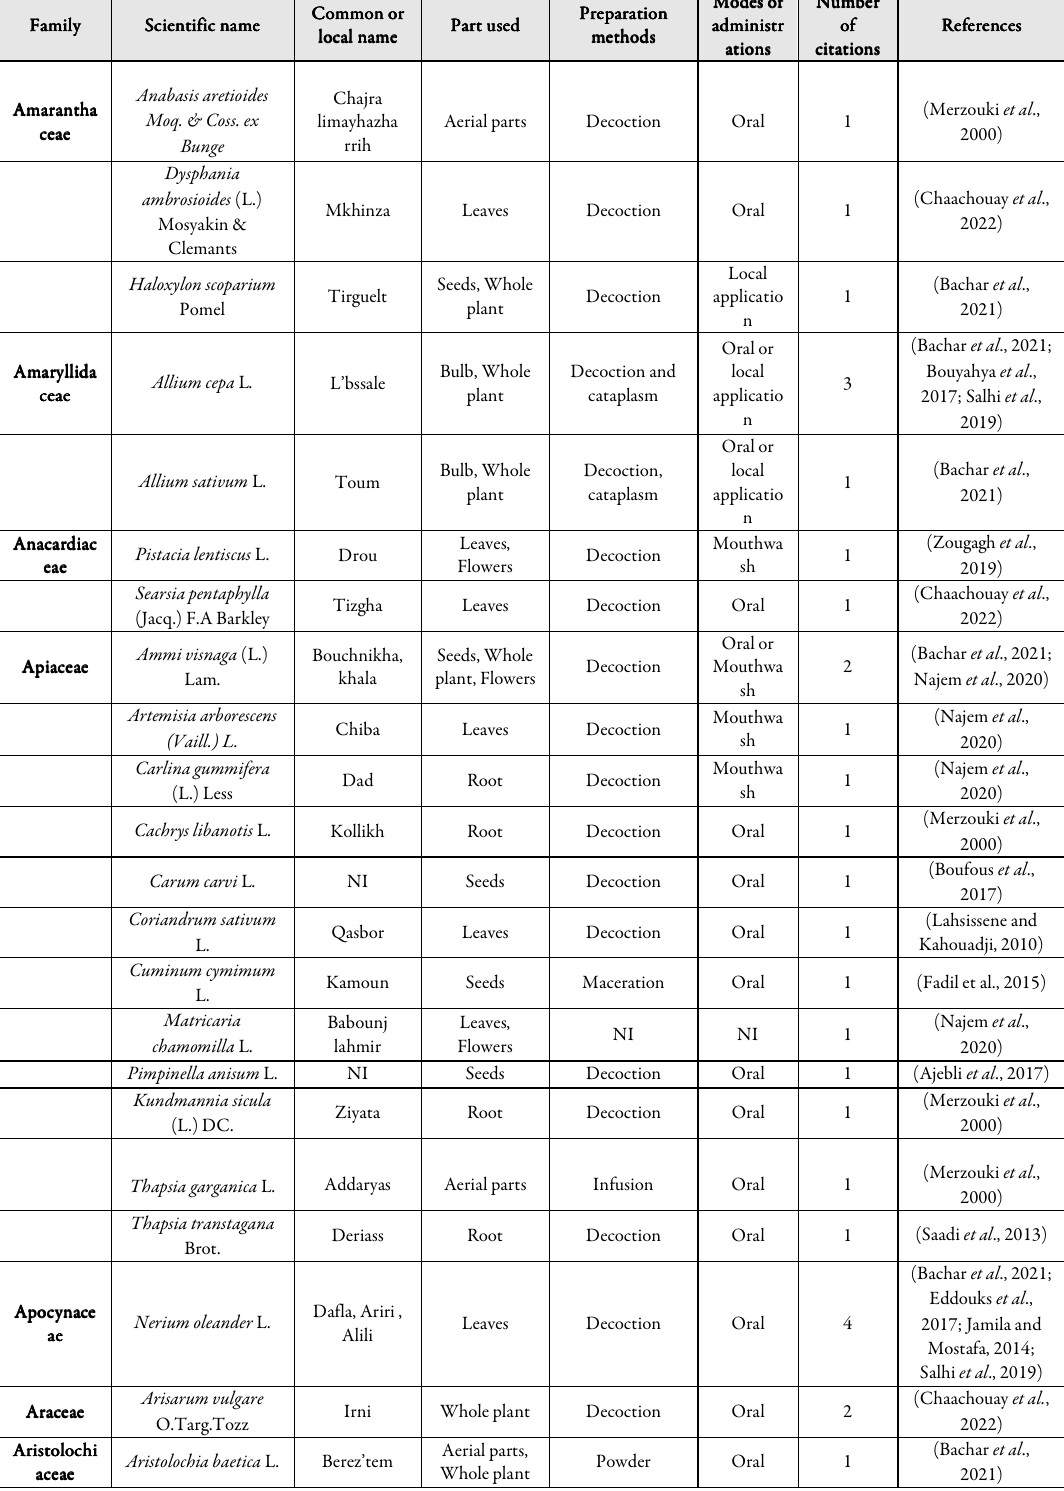
Table 1. Plants used in the inflammation treatment in Morocco, cited in ethnobotanical studies